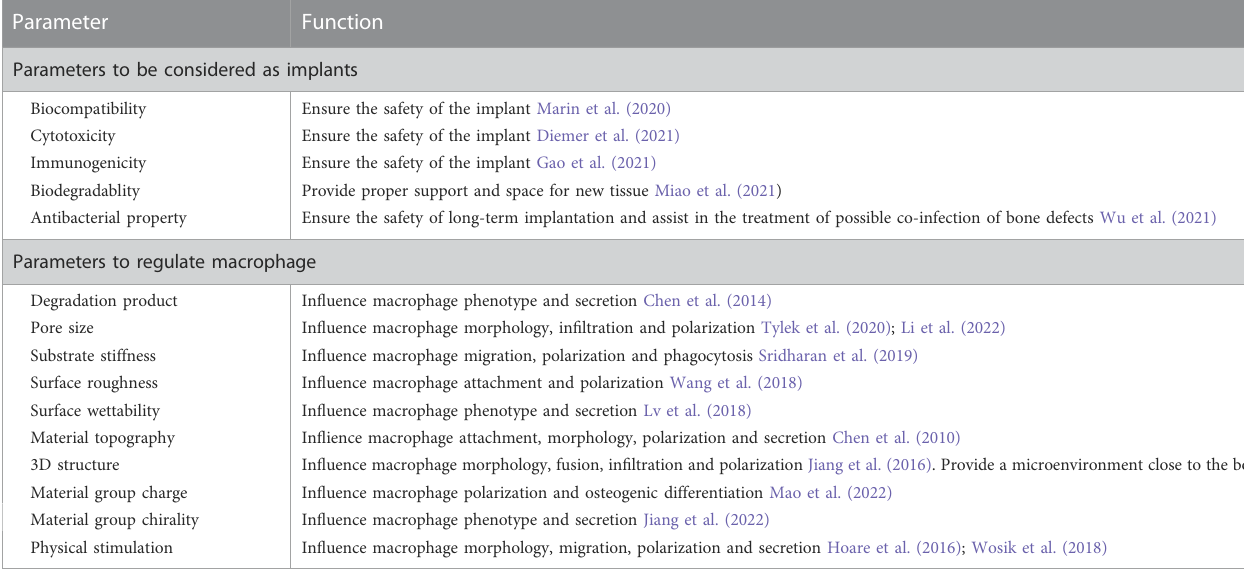
TABLE 2 Parameters affecting the regulation of macrophage function by